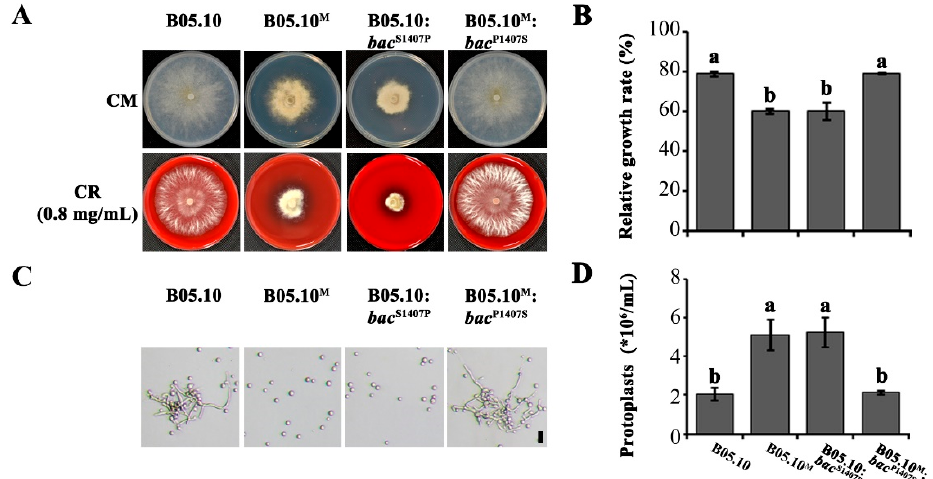
Figure 6. The S1407P mutation in bac affected the sensitivity of the fungus to cell wall stress. ( A ) Colony morphology of B05.10, B05.10 M , B05.10: bac S1407P , and B05.10 M : bac P1407S were shown after incubation with Congo Red (CR, the final concentration was 0.8 mg/mL) on CM medium for 3 days. ( B ) Relative mycelial growth rates of the strains shown in ( A ). The relative growth rate of each strain was the ratio of colony diameter on the CM medium supplemented with CR to CM medium (control) after incubation for 3 days. ( C ) Generation of protoplasts from mycelia of the above strains treated with cell wall-degrading enzyme for 2 h at 23 °C. Bar = 20 μ m. The mycelia were collected from the liquid ME after the conidia shaking 16 h (the initial concentration of conidia was 10 8 /mL). ( D ) Number of protoplasts of the strains shown in ( C ). Different letters on the columns indicate significant differences ( p < 0.05).